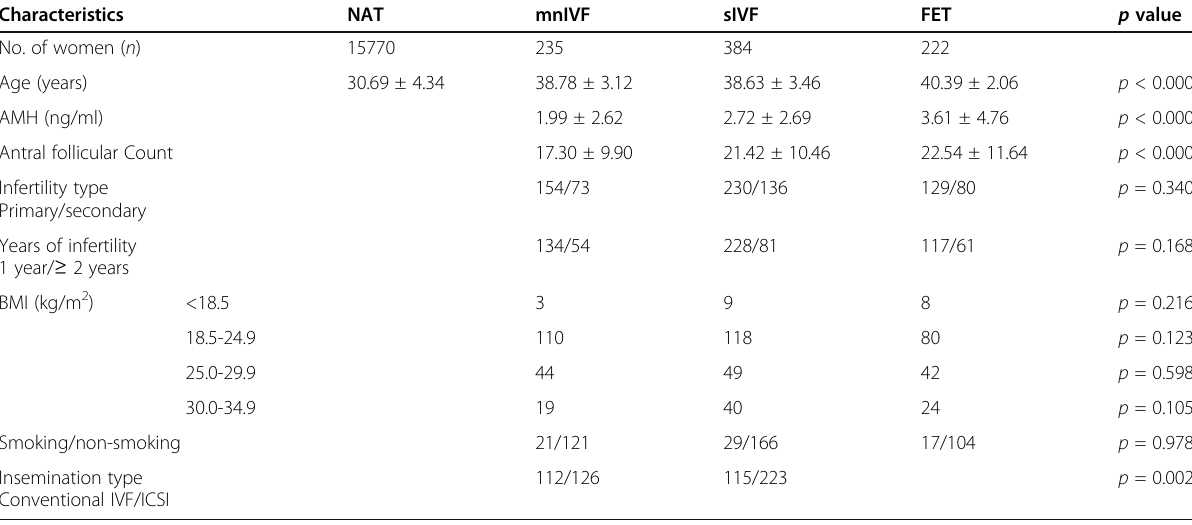
Table 1 Demographic characteristics of included patients Characteristics